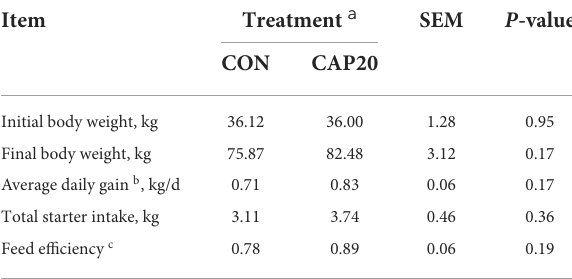
TABLE 3 Calf starter intake, body weight, average daily gain, and feed efficiency of calves born from dams supplemented with either 0 or 20 mg/kg dry matter of Capsicum oleoresin